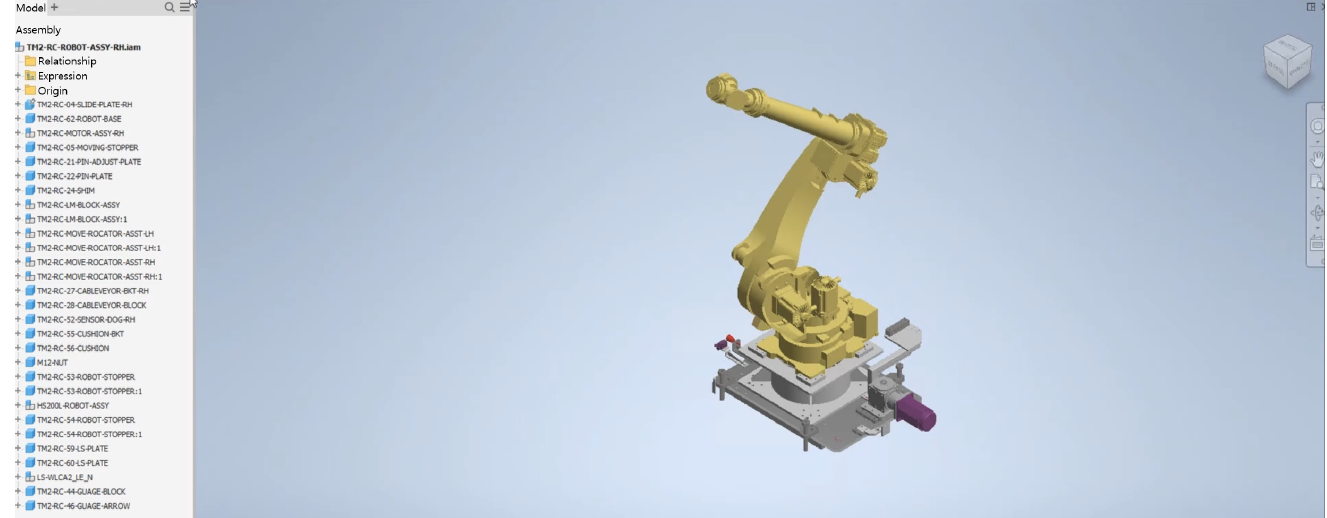
Figure 10. .iam Design File with Inventor.